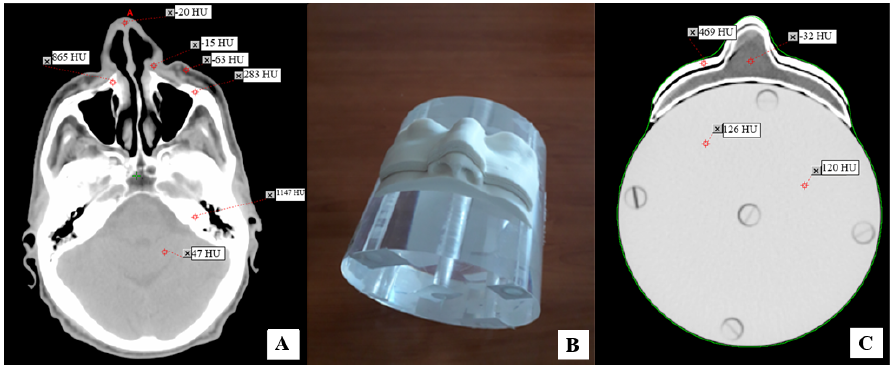
Figure 4. CT scans of the objects of interest: ( A ) CT scan of real HNC patient, with indicated HU values for different organs; ( B ) image of phantom–phantom–bolus assembly; ( C ) CT scan of the PMMA head phantom with attached 3D-printed phantom and 3D-printed bolus on it, with indicated HU values.